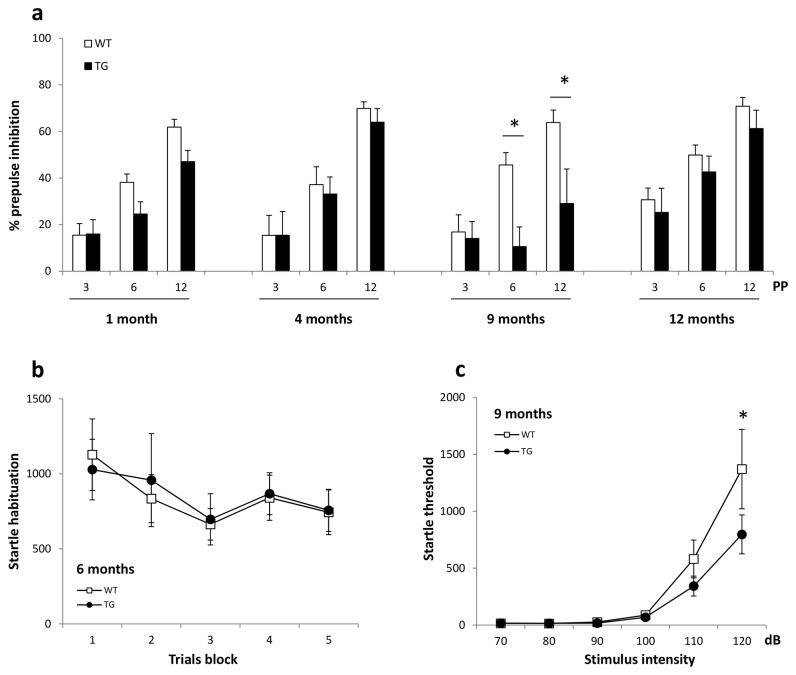
Startle testing.Results are expressed as Mean ± SEM. (a) Prepulse inhibition. A 2 way-ANOVA revealed a GENOTYPE difference in 9 months old BACHD rats especially at PP 6 and PP 12; however any significant differences were found in 1, 4 and 12 months old rats. (b) Startle habituation amplitude in 6 months old rats. Each trial consisted of 10 blocks of 120 dB startle stimuli. WT and TG rats presented a normal startle habituation. (c) Startle threshold. Amplitude to varying startling stimulus intensities in 9 months old rats. WT and TG response amplitude increased with higher stimulus intensities. No GENOTYPE effect was observed. However, a significant difference was detected at 120 dB. Asterisks indicate statistical significance in BACHD rats (*p < 0.05).